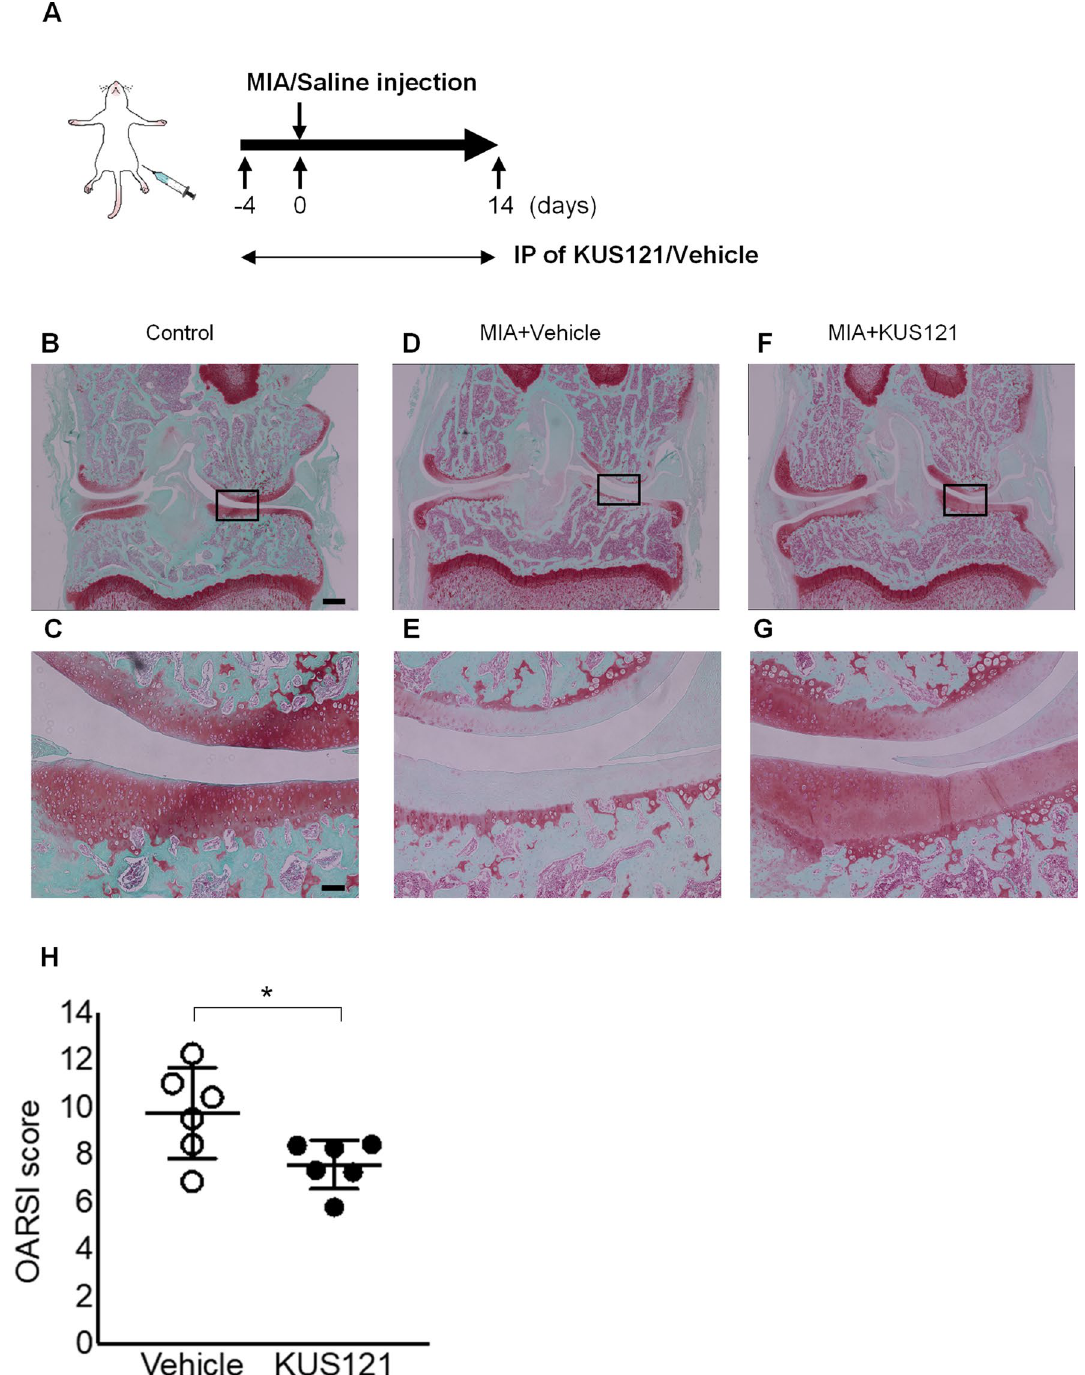
Figure 3. Efficacy of KUS121 in monosodium iodoacetate-induced osteoarthritis rat model. ( A ) Monosodium iodoacetate (MIA, 0.5 mg) was intra-articularly injected into the knee joint of rats to create an osteoarthritis (OA) model. KUS121 was administered daily intraperitoneally (IP) from 4 days before until 14 days after MIA injection. ( B – G ) Knee joints of OA rats treated with either KUS121 ( F , G ) or vehicle ( D , E ) were stained with Safranin-O and Fast green. ( C , E , G ) Show magnified views in ( B , D , F ). Scale bars, 600 µm in ( B , D , F ); 100 µm in C, E, G. ( H ) The stained knee joints were graded on a scale of 0–24 using the Osteoarthritis Research Society International (OARSI) scoring system. Independent data points for OARSI scores with mean ± standard deviation are shown. *p < 0.05, vs MIA without KUS121, Mann–Whitney U test, N =